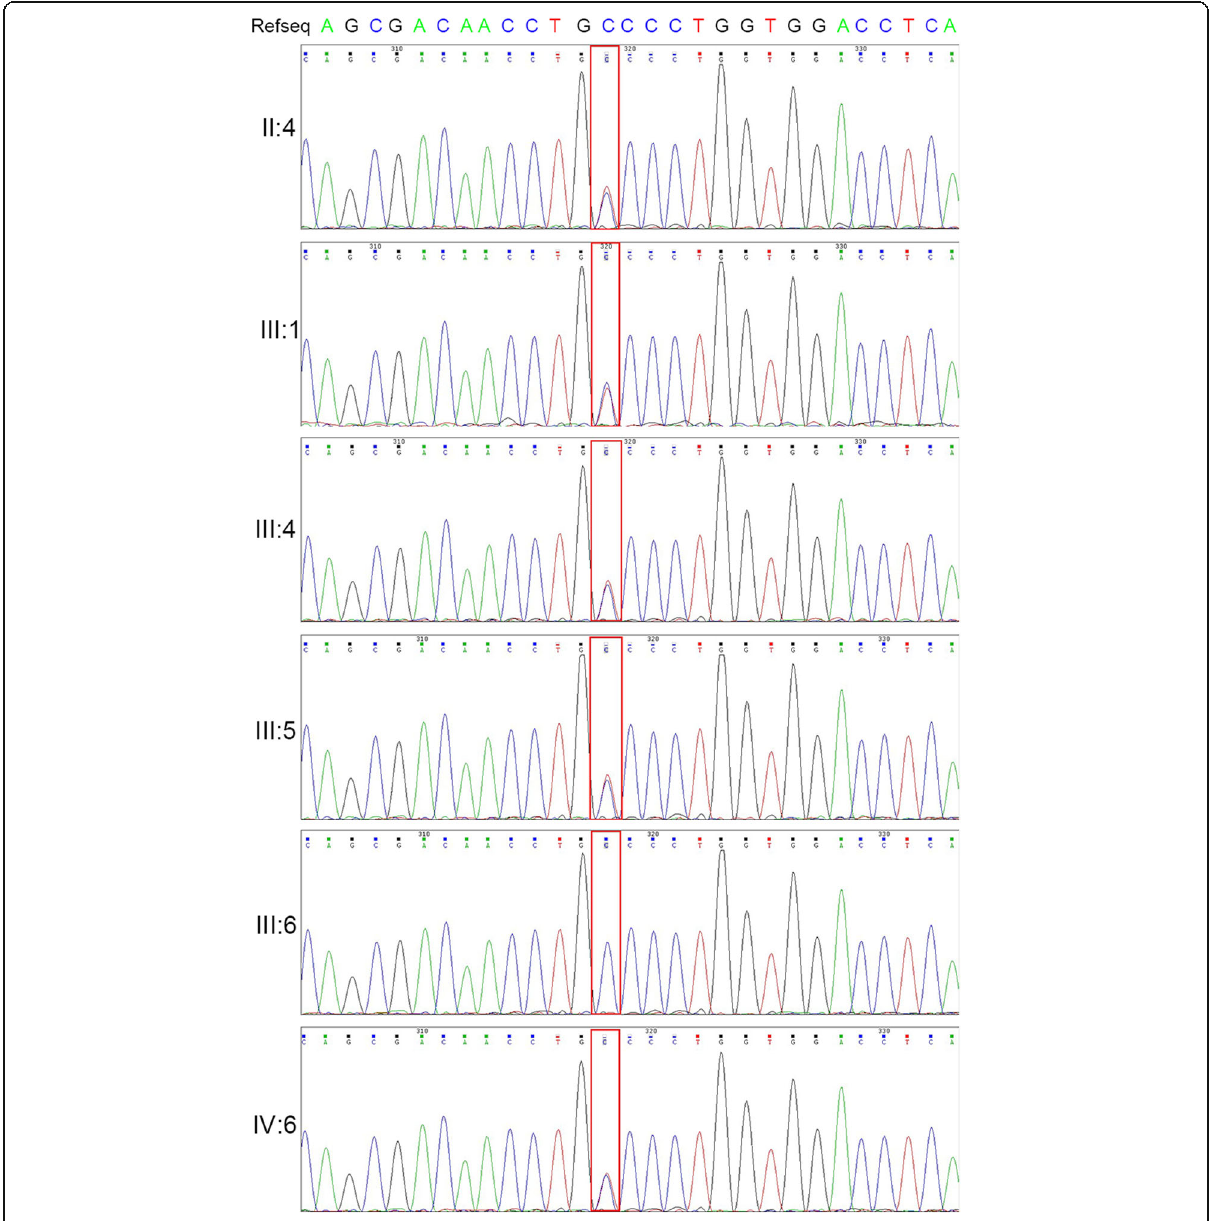
Fig. 3 Identification of a novel NOG mutation. DNA sequencing profile around the position c.C124. The proband ’ s mother (III: 6) is a normal individual without SYM1. The red rectangle indicates the heterozygous mutation in the proband (IV: 6) and her affected family (II: 4, III:1, III:4,